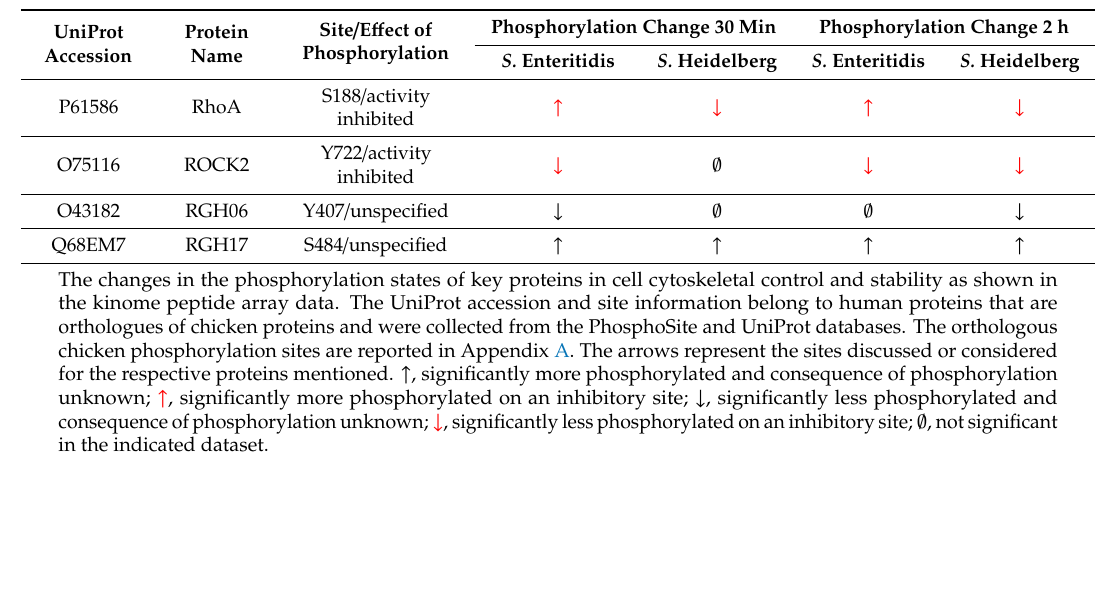
Table 2. Phosphorylation changes in major cytoskeletal proteins during S. Enteritidis and S. Heidelberg infection of chicken